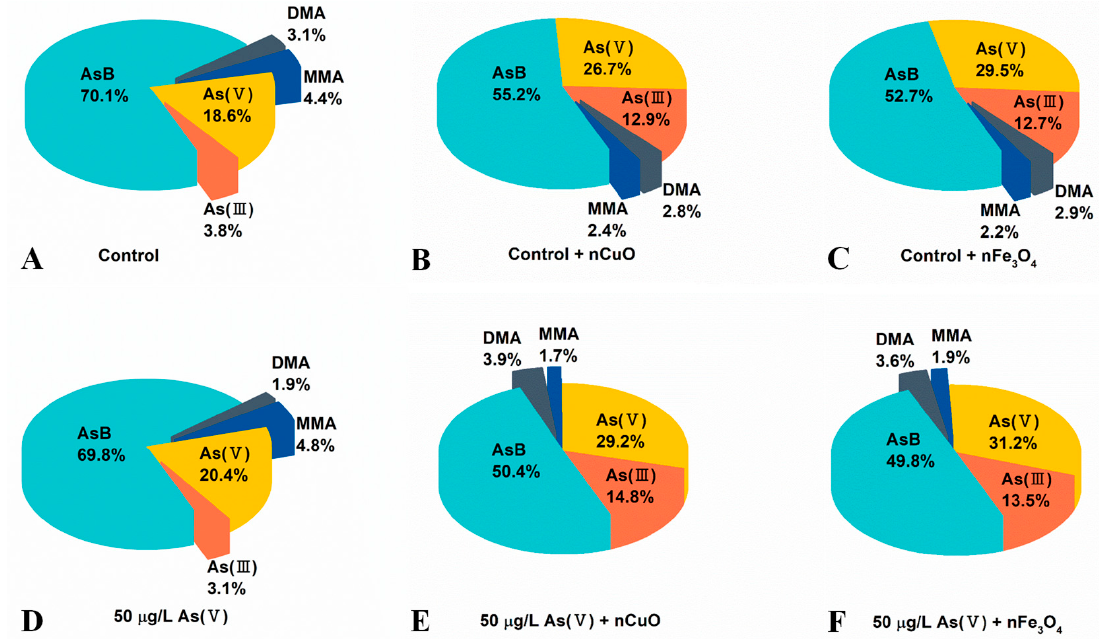
Figure 4. Content of As speciation in mussels after different exposure (organic monomethylarsonic acid (MMA), dimethylarsinic acid (DMA), and arsenobetaine (AsB)). ( A ) Control: Mussels exposed to artificial seawater for 21 days. ( B ) Control + nCuO: Mussels exposed to 1 mg/L nCuO for 2 weeks after control exposure. ( C ) Control + nFe 3 O 4 : Mussels exposed to 1 mg/L nFe 3 O 4 for 2 weeks after control exposure. ( D ) 50 µ g/L As(V) only: Mussels were cultured in 50 µ g/L As(V) solution for 21 days. ( E ) 50 µ g/L As(V) + nCuO: Mussels exposed to 50 µ g/L As(V) + nCuO for 2 weeks after 50 µ g/L As(V) exposure. ( F ) 50 µ g/L As(V) + nFe 3 O 4 : Mussels exposed to 50 µ g/L As(V) + nFe 3 O 4 for 2 weeks after 50 µ g/L As(V) exposure.